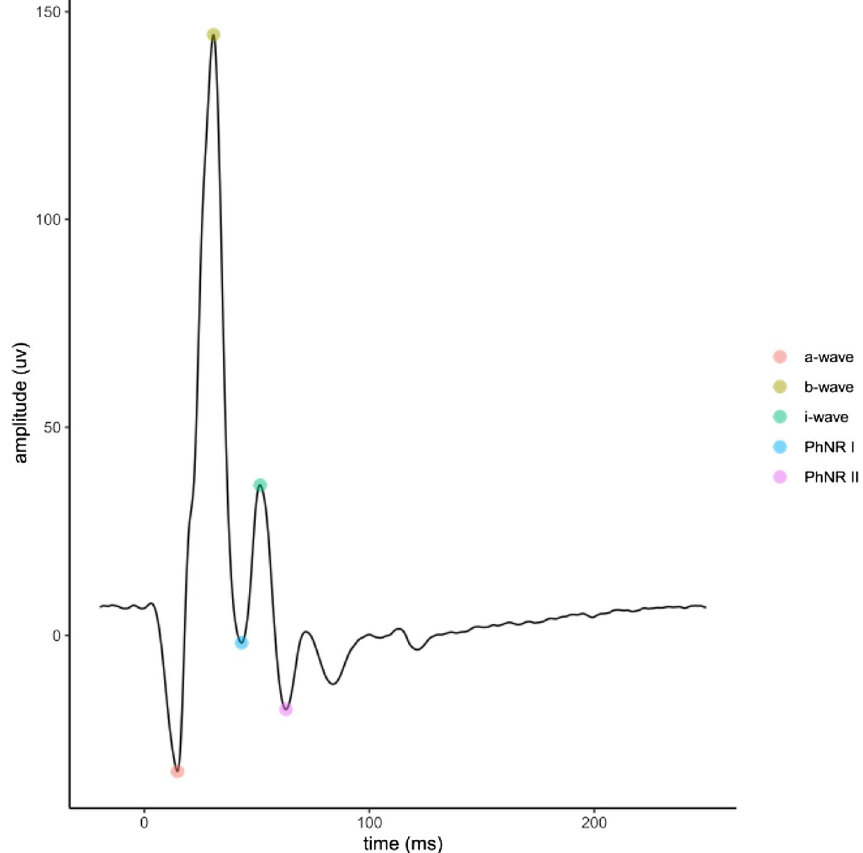
Figure 1. Typical electroretinogram trace (ERG) for the first step of red flash on blue background. Automatic marker placement is